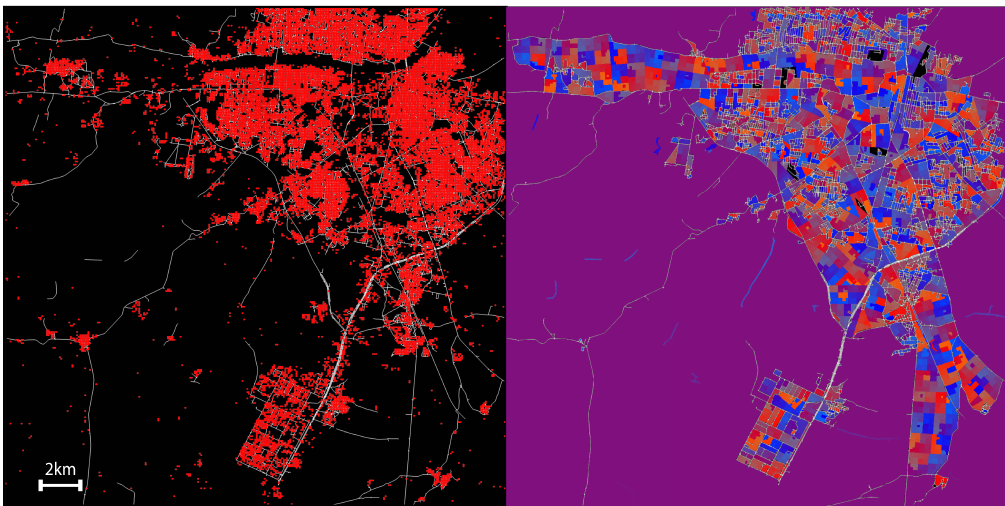
Figure 16. Population Density and Parcel Subdivision. ( Left ) We show an example city in which the population density is indicated in red and our roads are drawn in white; ( Right ) We show an experiment of smart parcel subdivision, applicable to our addressing